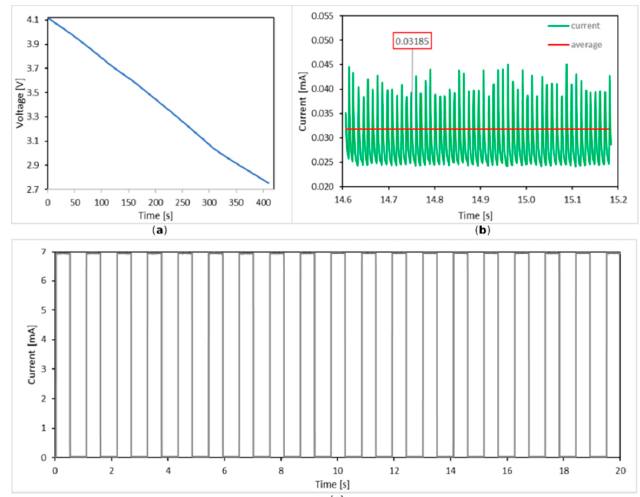
Figure 7. Tag power consumption measurements in the low power consumption scenario. ( a ) The voltage drop in supercapacitor without external source. ( b ) Extraction of the low power mode and the average of the current consumption. Here it can be seen that this mode lasts the 0.5 s. ( c ) Extraction of the first 20 s of graphic ( a ), but in this case, the current draw of the tag is represented. The peaks represent when the transceiver changes to reception mode every 0.5 s.